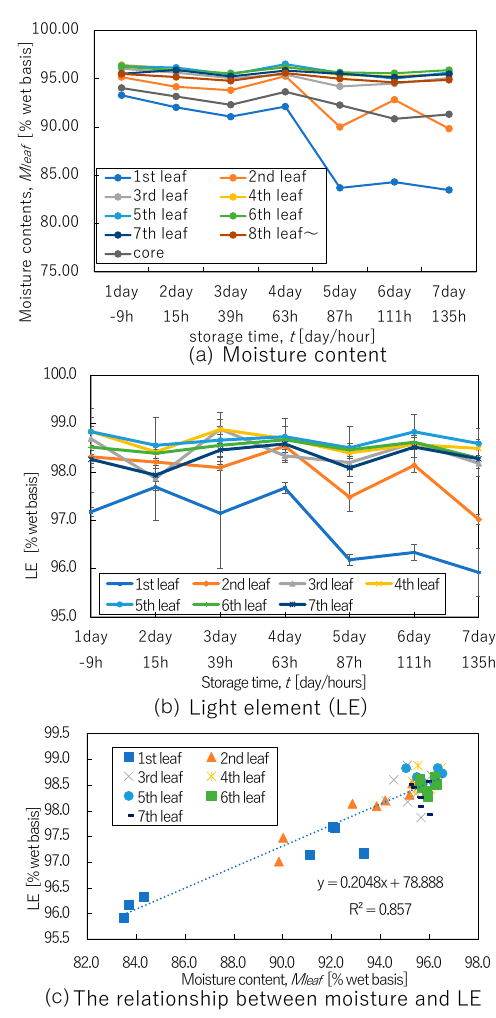
Fig. 7: The change of standardized moisture contents with two changing Fig. 7 The change of standardized moisture contents with two changing points. 688 points. Fig. 8: Moisture contents and Light Elements